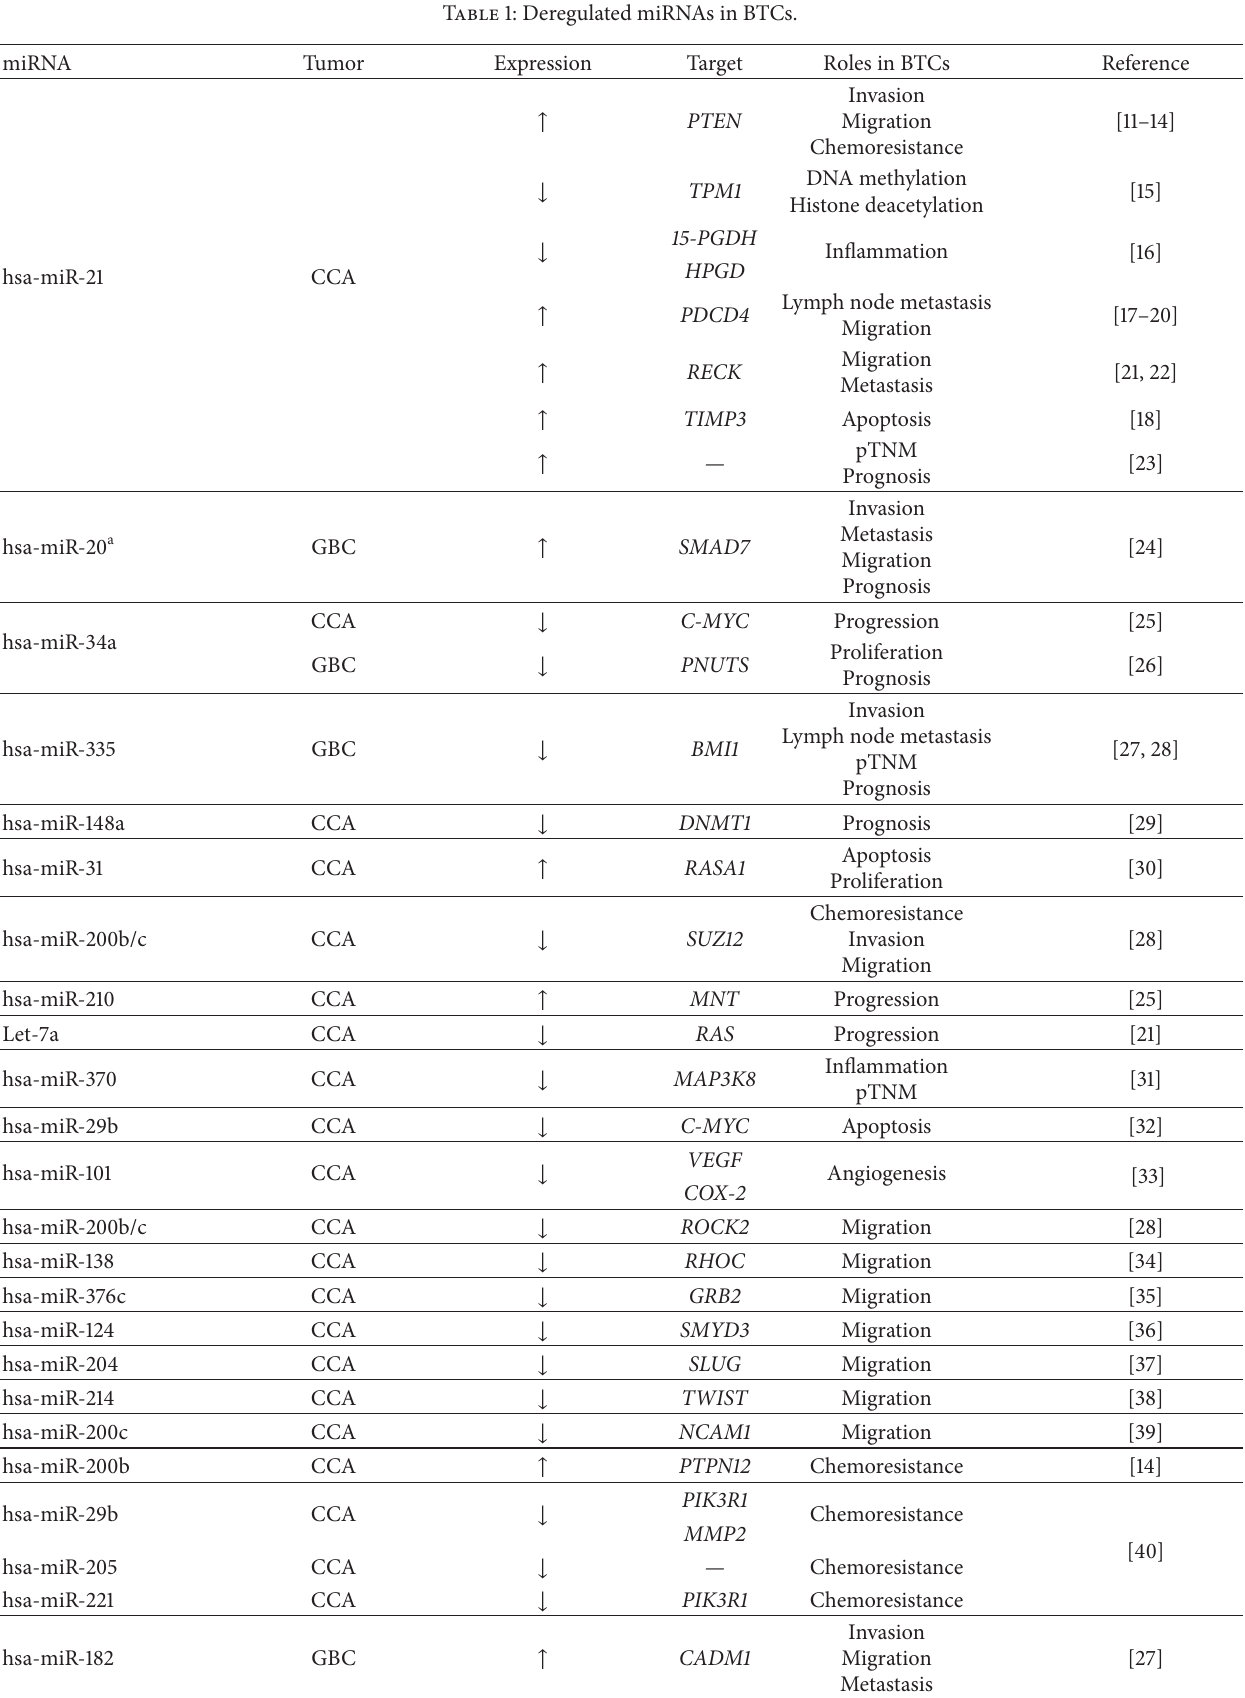
Table 1: Deregulated miRNAs in